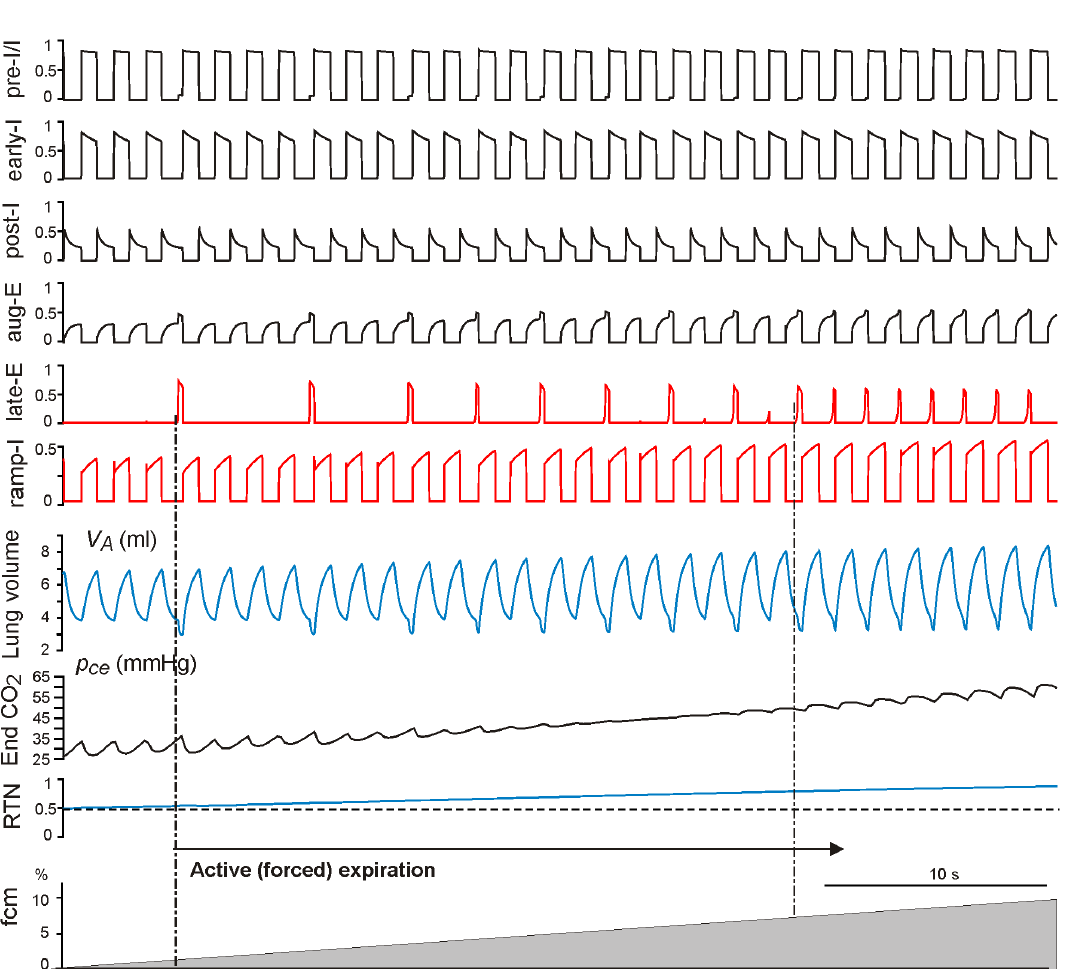
Figure 6. Simulation of progressive hypercapnia in the vagotomized model. The continuous increase of hypercapnia (the grey ramp at the bottom) was induced by increasing CO 2 content in the mouth f cm from 0 to 10%. Active expiration starts with the first appearance of late-E discharges (indicated by the left vertical dot-dashed line at f cm =1.2%) and reaches the regime with the 1:1 ratio of late-E to ramp-I activations at f cm =7%. Again, each late-E discharge, representing the activity of AbN output, actuates the abdominal pump that reduces the baseline level of lung volume (see in the V A trace).